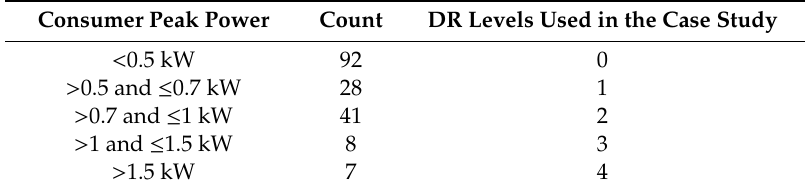
Table 5. Consumer categories based on their peak power demand and maximum number of demand response (DR) levels used for each